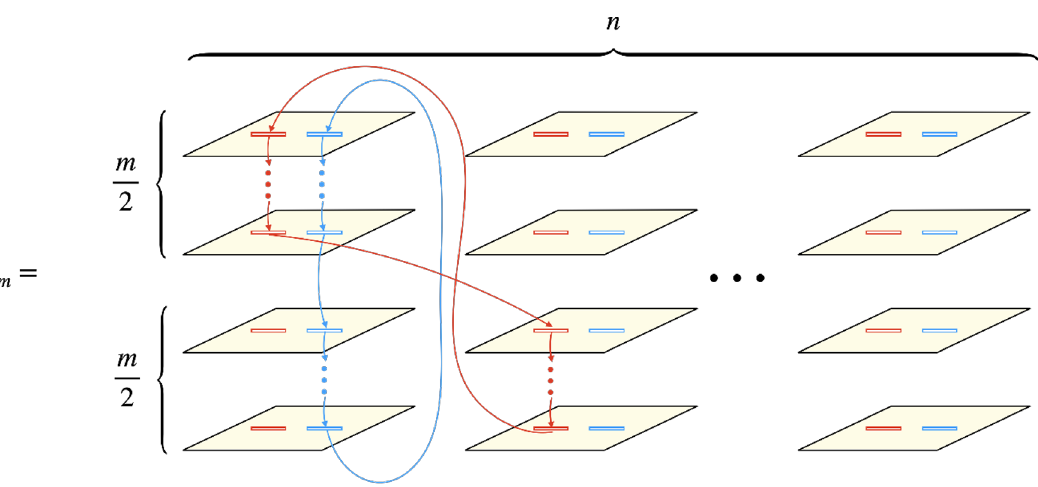
Figure 3 . The replica trick for reflected entropy requires two replica numbers, n and m . The copies are glued cyclically in m for region B for each value of n (blue line). For region A , the gluing mixes different n ’s in the order shown by the red line. Note that it is necessary for m to be